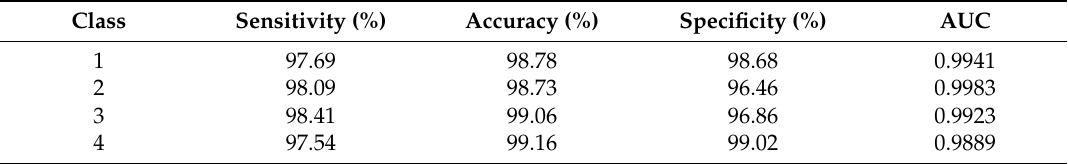
Figure 4. ROC curves of the proposed hybrid ANN-GA classifier. Table 7. Performance results of the hybrid ANN-GA classifier using different criteria: sensitivity, accuracy, and specificity, and area under the ROC curve (AUC). Classes: 1. unripe; 2. half-ripe; 3. ripe; 4. overripe.